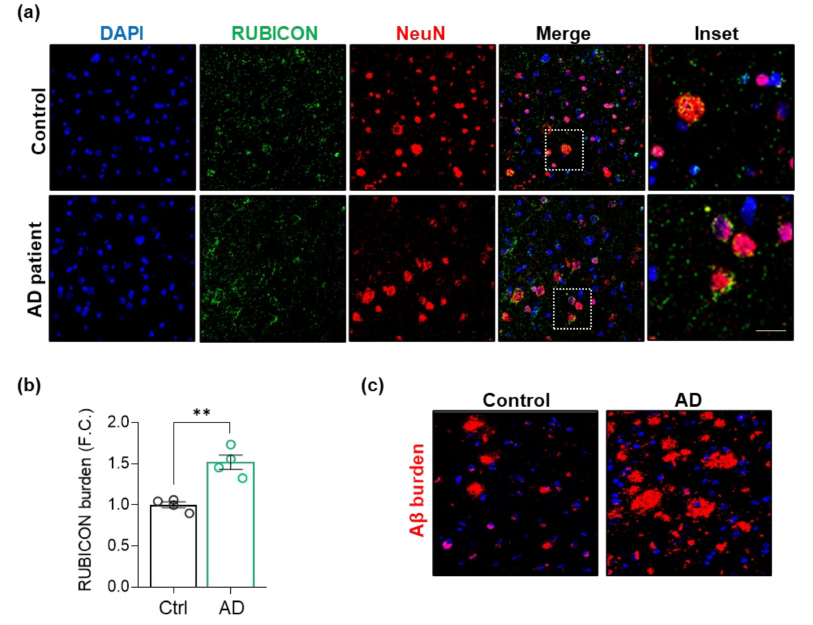
Figure 2. RUBICON is located in neurons, and its levels are increased in postmortem sections of the frontal cortex from AD patients. ( a ) Z-stack of confocal images showing detection of RUBICON (green), NeuN (red), and nuclei stained with DAPI (blue). Images represent controls (upper row, n = 4) and AD patients (lower row, n = 4). Scale bar: 50 µ m. ( b ) Quantification of the intensity of RUBICON fluorescence in sections of four AD patients and four healthy controls. FC, fold change. ( c ) Representative Z-stack of confocal immunocytochemistry images detecting amyloid β plaques (4G8 antibody, red) and nucleus (DAPI, blue) from control and AD patients’ frontal cortex sections. Scale bar: 50 µ m. Data are mean ± SEM. ** p < 0.01 as determined by a Mann-Whitney t -test.